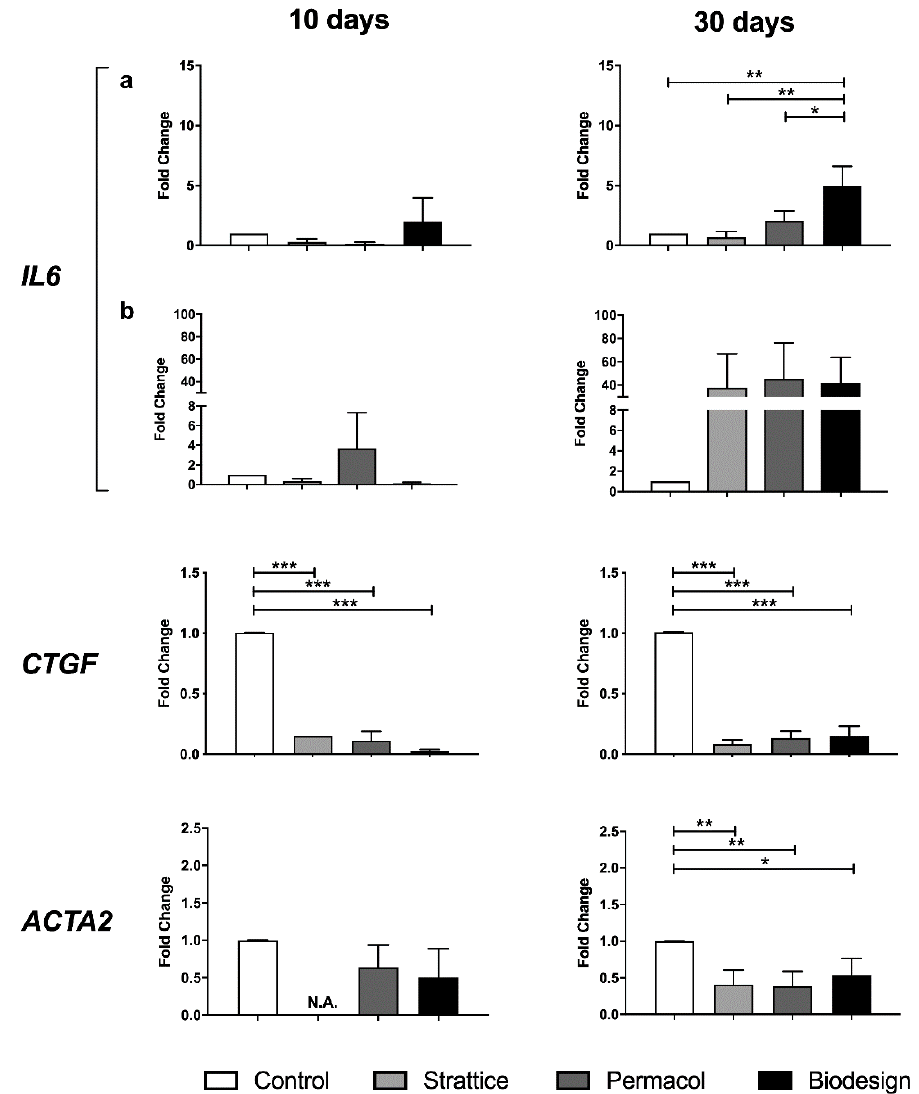
Figure 6. Changes in the levels of IL-6, CTGF, and α -smooth muscle actin following growth on the different types of matrices for 10 or 30 days, compared to the control condition. Expression from fibroblasts grown on plastics (control), Strattice, Permacol, Biodesign at transcript ( a ) and protein ( b ) levels. Values are the means of four independent experiments ± SE. The results were analyzed with ANOVA. Asterisks indicate significant differences (* p < 0.05; ** p < 0.01; *** p < 0.001). N.A. in transcript graphs ( a ) indicates that expression was not analyzed since the amount of RNA extracted from the sample was not sufficient to analyze all genes of